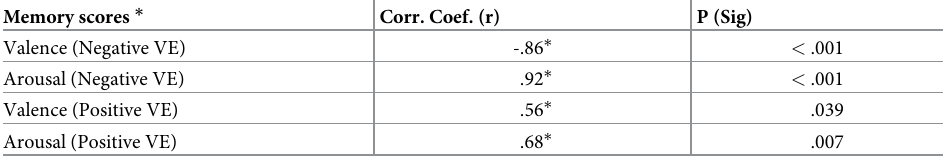
Table 2. Correlations between memory accuracy and mean valence and arousal ratings across events/objects for the positive and negative VE conditions. Memory scores * Corr. Coef. (r)